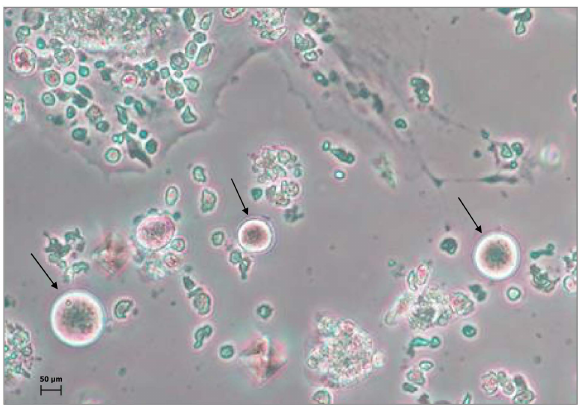
Figure 2. Ddx4 + oogonial stem cells (OSCs). Representative image depicts the oocyte-like di ff erentiation of OSCs (black arrows) after 21 days of culture in the presence of fibroblasts feeder layer. Although present in variable size during their di ff erentiation, the largest cells (diameter of approximately 80–90 µ m) acquired oocyte-like features, with prominent nuclei and perinuclear accumulation of organelles. By contrast, smaller cells were considered immature OSCs and might represent the oogonial stem cell